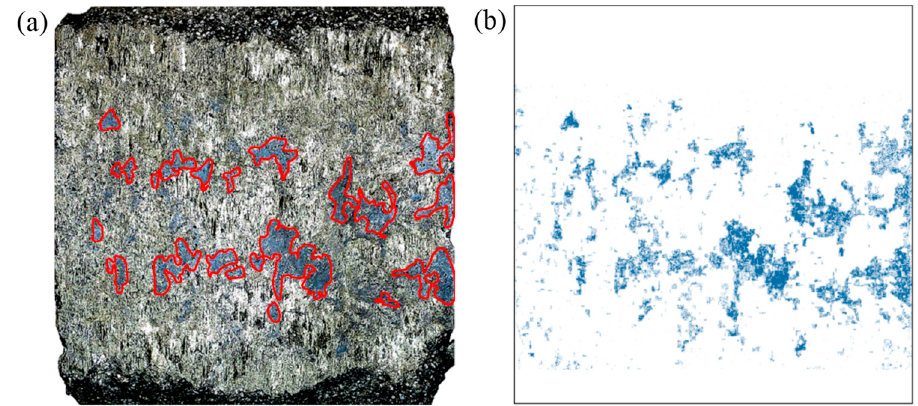
Figure 8. ( a ) Surface wear area and scratches of specimen H3 after cyclic shear. ( b ) The image binarization method was used to distinguish the worn area from the unworn area.